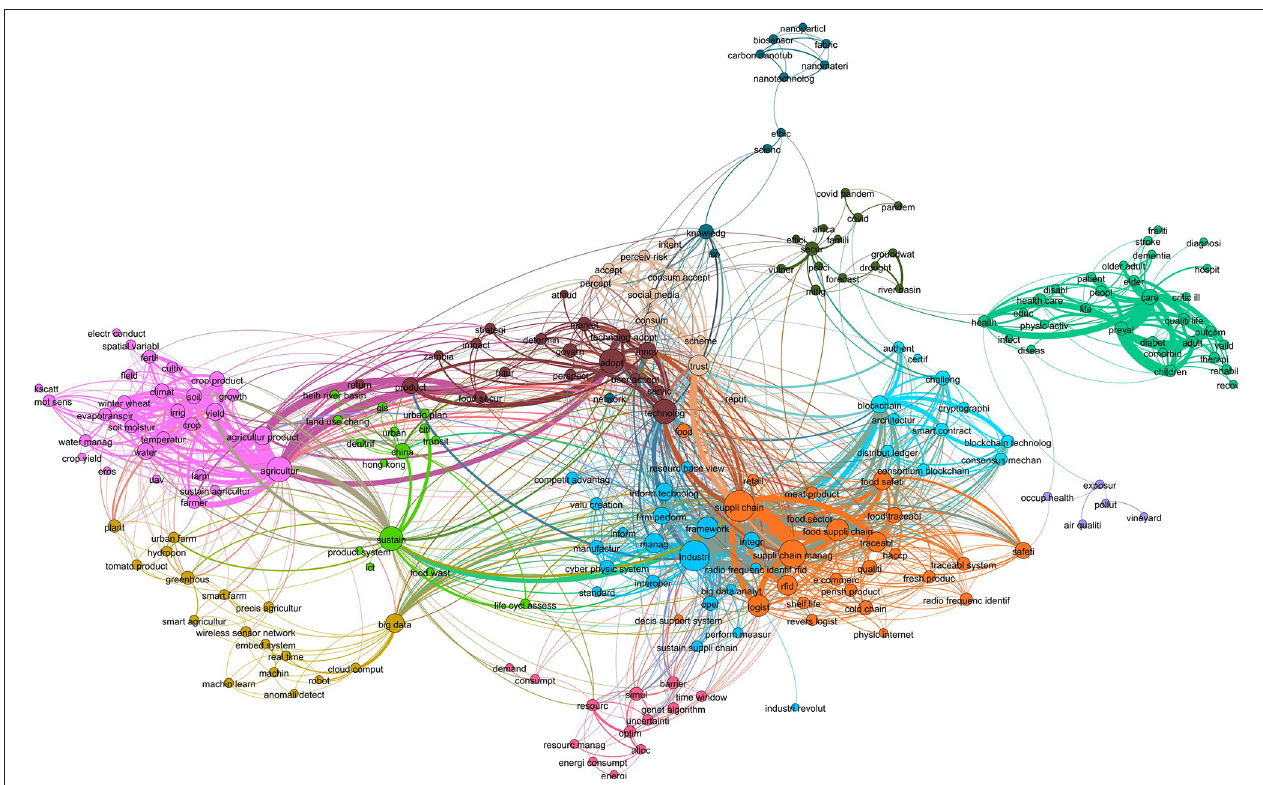
FIGURE 3 | Cooccurrence network of B-terms between food security and IoT.